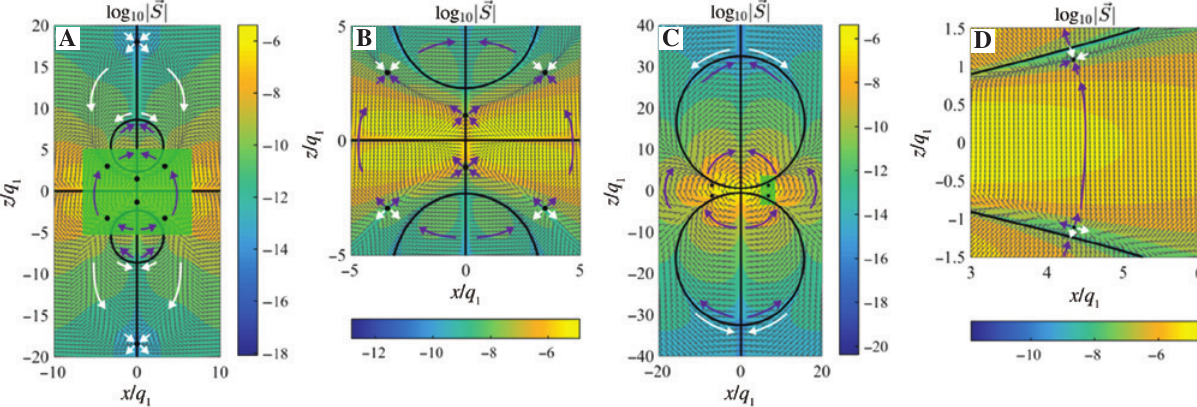
Figure 6: Poynting vector of the TE FD pulse at focus. Contour and arrow plot of the logarithm of the Poynting vector in the xz plane for the single- (A, B) and 1½-cycle (C, D) pulse. Panels (B) and (D) present zoom-ins of the areas highlighted by green in (A) and (C), respectively. Solid black lines, circles and dots mark the zeros of the Poynting vector. Purple and white arrows indicate areas with forward and backward energy flow, respectively. Note that in regions of backward energy flow, the Poynting vector takes values many orders of magnitude smaller than in the forward flow